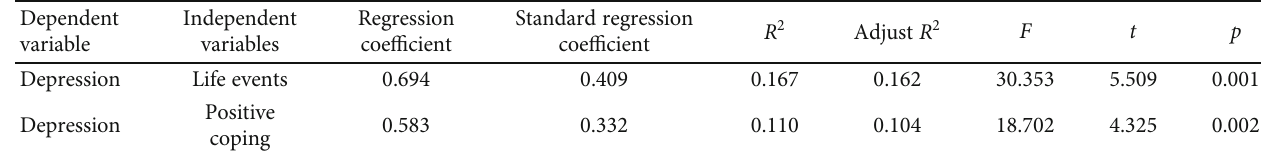
Table 3: Linear regression of depression and life event and coping style.